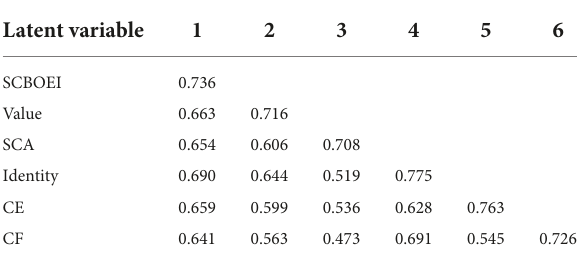
TABLE 8 Discriminant validity test.